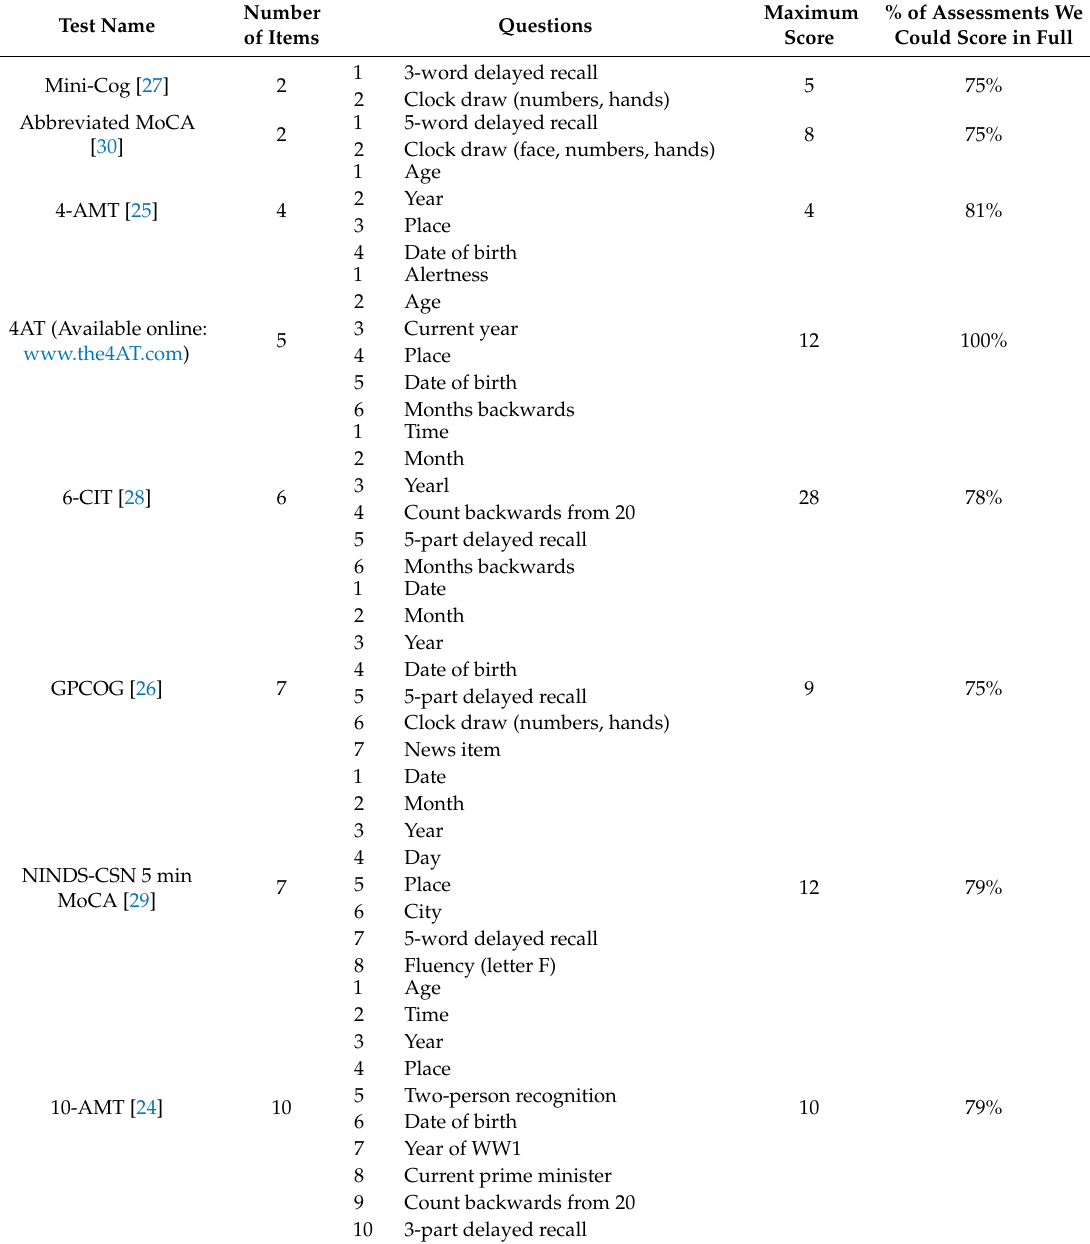
Table 2. Short cognitive tests ordered by number of